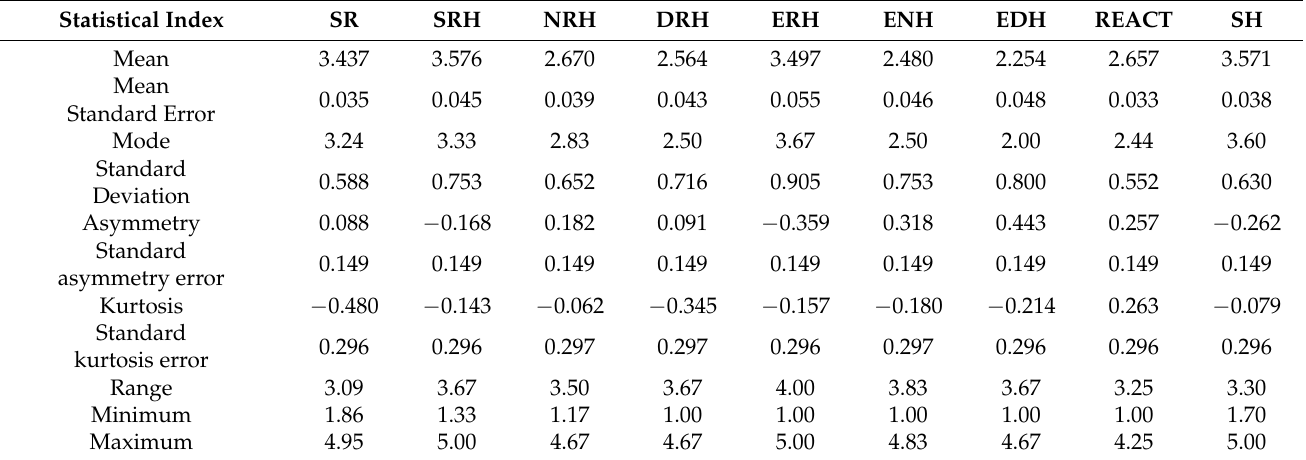
Table 4. Preliminary